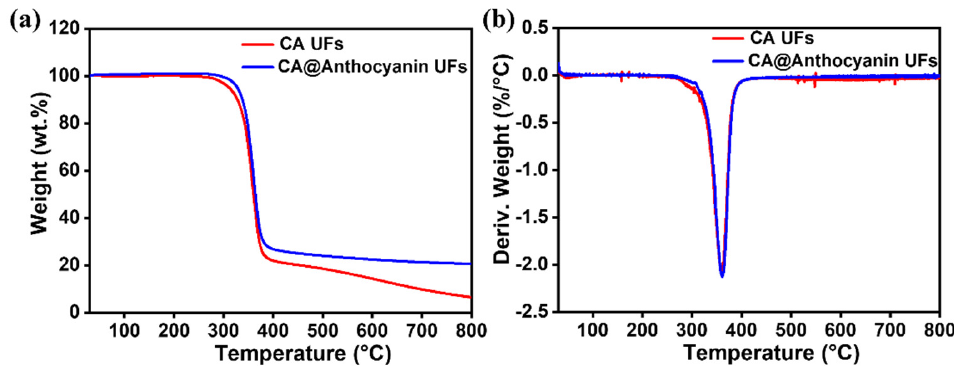
Figure 3. ( a ) TGA and ( b ) DTG curves of the CA UFs and CA@Anthocyanin UFs under N 2